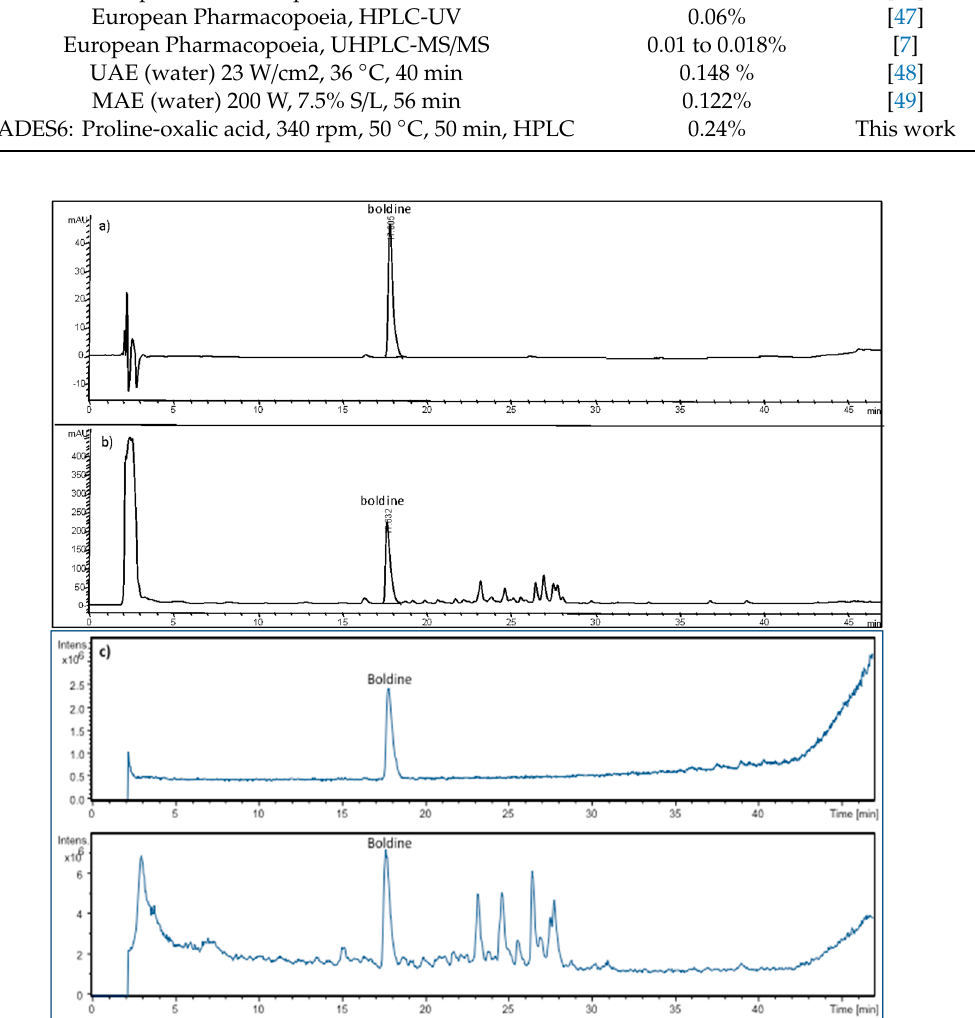
Figure 3. Illustrative HPLC-PDA chromatograms of boldine standard ( a ) and Peumus boldus leaves extracted with NADES6 ( b ). HPLC-IT/MS chromatograms of boldine standard and Peumus boldus leaves extracted with NADES6 ( c ). HPLC separation was performed in reverse phase under gradient. The trace correspond to the signals recorded at 304 nm.